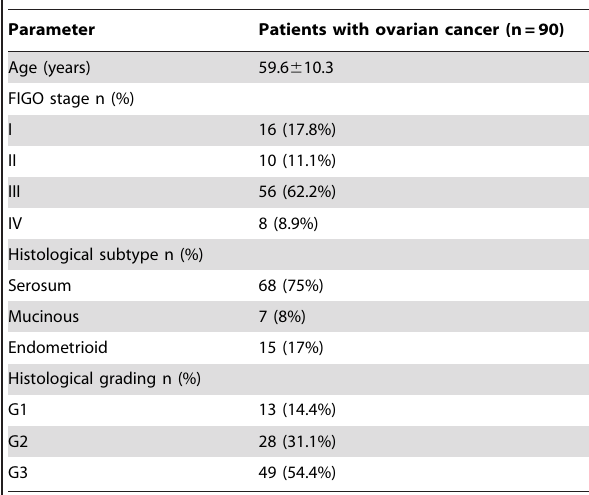
Table 1. Baseline characteristics of the study